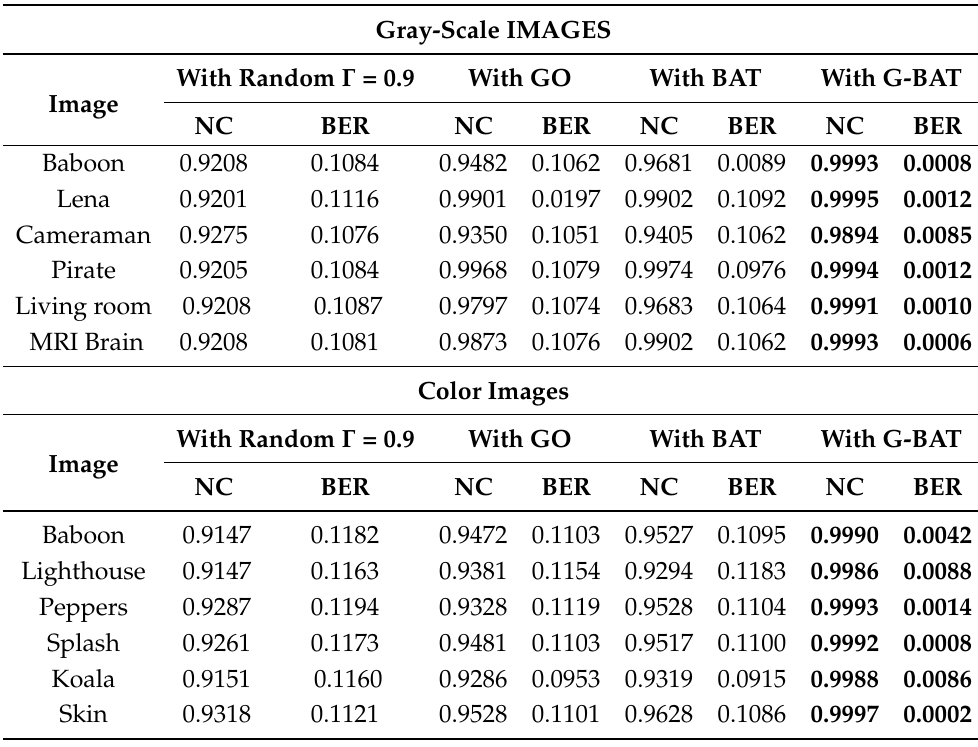
Figure 10. BER for the 10 test aerial cover images with random Γ , with Go, with BAT and with G-BAT under zero attacks. Table 4. NC and BER for normal (gray-scale and color images) images with random Γ = 0.9 and with optimized Γ using GO, BAT and G-BAT under zero